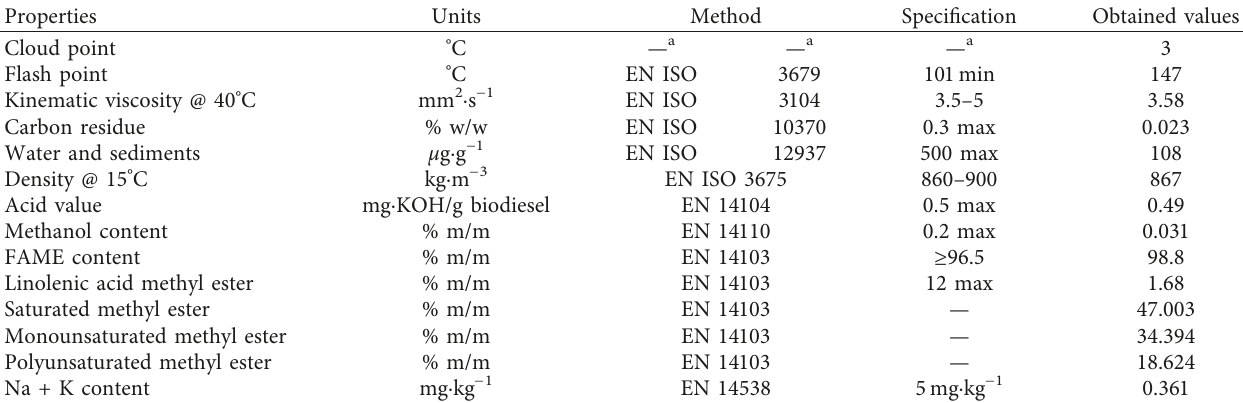
Table 2: Methods used to determine physical and chemical properties of the Amazon sailfin catfish biodiesel.